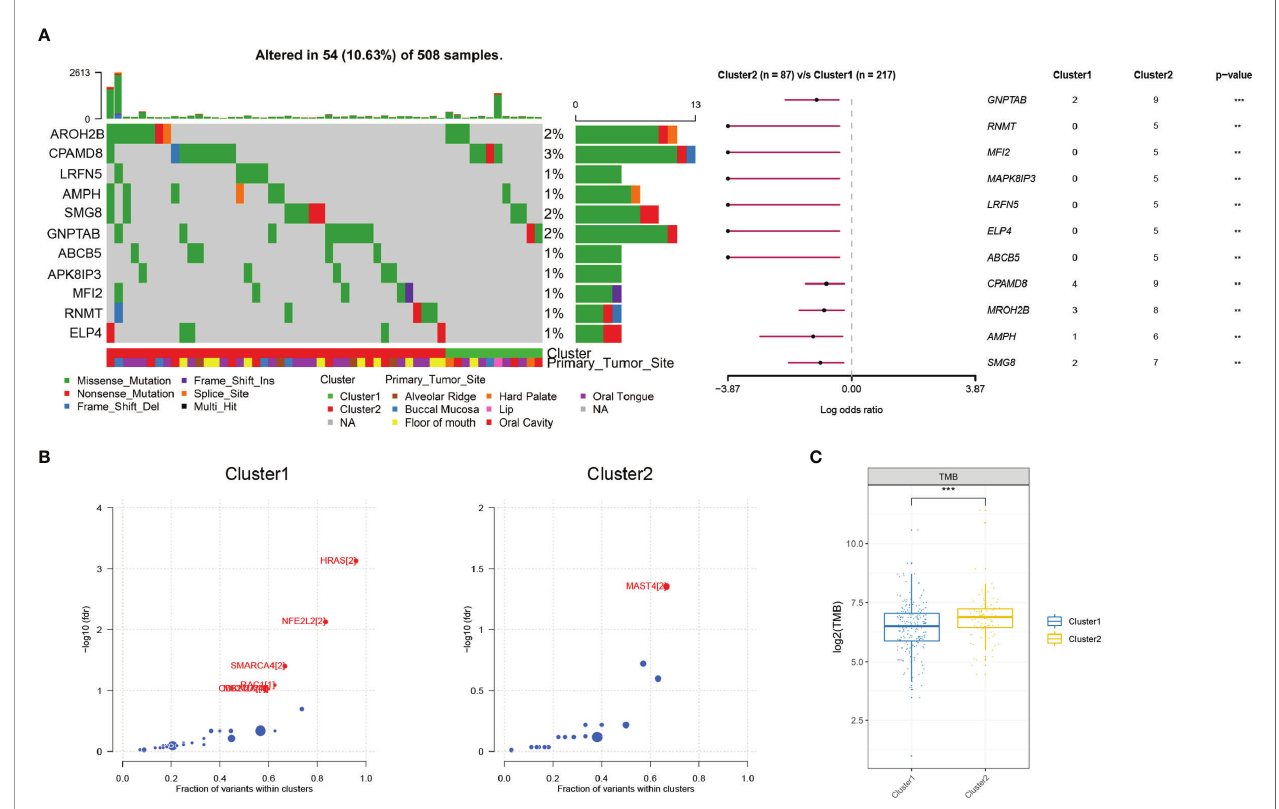
FIGURE 3 | Mutational alterations between two hypoxia clusters in the TCGA cohort. (A) Top 11 most differently mutated genes depicted in the two clusters. (B) HRAS or MAST4 respectively identi fi ed as the driver gene candidate for cluster 1 or cluster 2. (C) Tumor mutational burden signi fi cantly increased in cluster 2 (** P < 0.01, *** P <